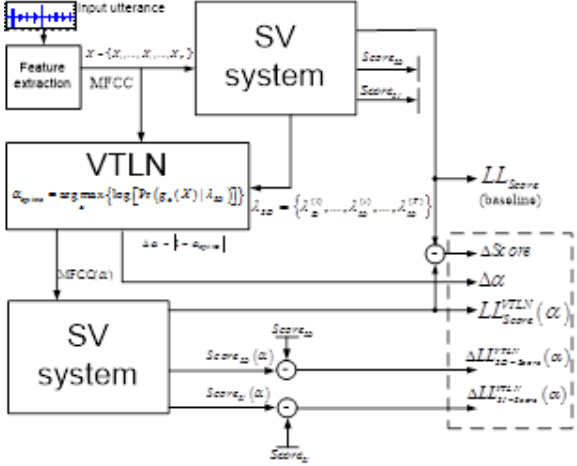
Figure 1. The proposed scheme to obtain new classifiers with VTLN in speaker verification systems.